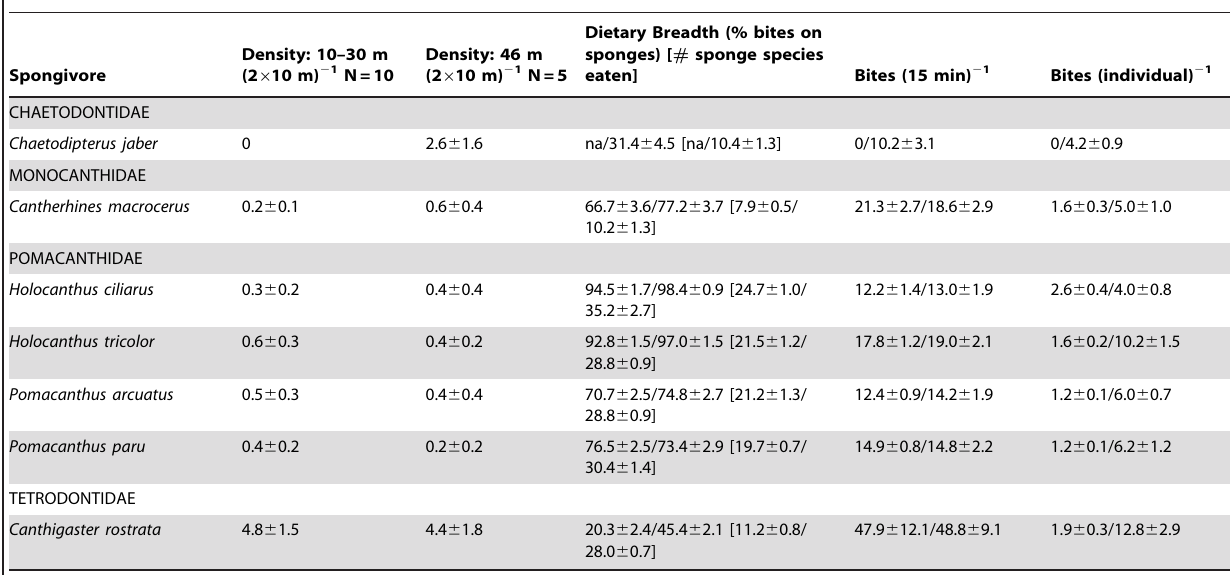
Table 1. Depth-specific spongivore densities and their diet on Carrie Bow Cay, Belize.